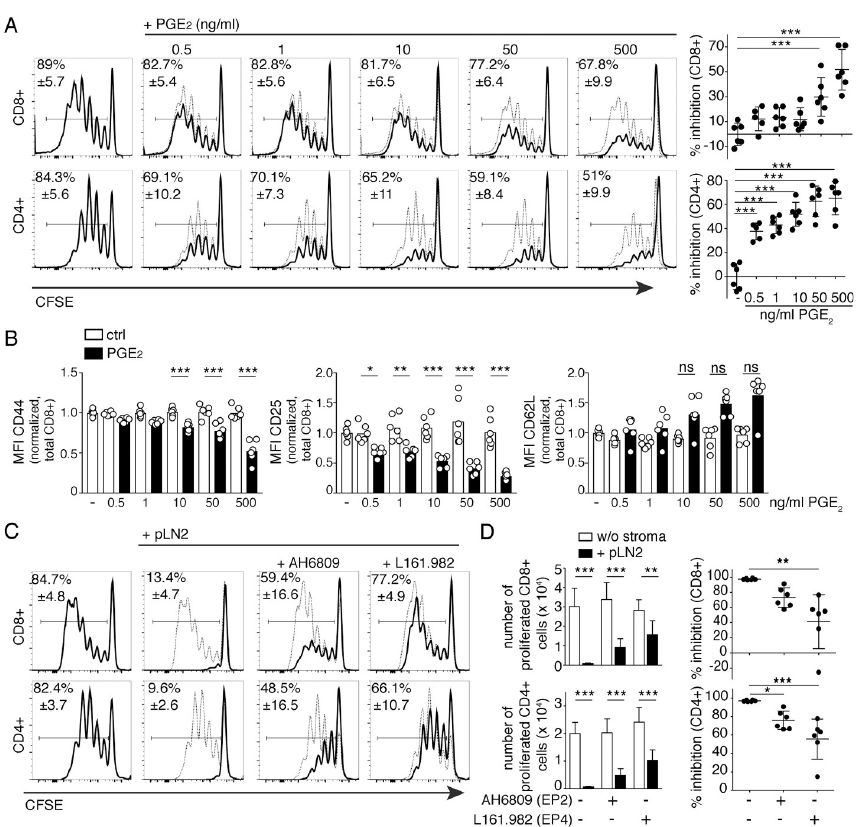
Fig 2. LN FRCs constitutively produce the COX-dependent mediator PGE 2 , which enables inhibition of T-cell activation and proliferation mainly via EP4 receptor signaling. Flow cytometric analysis of CFSE dilution in CD8+ and CD4+ T cells that were activated with α CD3/28 DynaBeads and cultured for 3 d. (A) Left side: CFSE dilution profiles of T cells in presence of the indicated concentrations of PGE 2 (black line) or solvent control (ethanol; thin line), with, on the right side, scatter plots showing the percentage inhibition of T-cell proliferation. (B) Expression level (MFI) of CD44, CD25, and CD62L on total CD8+ T cells in presence of PGE 2 . (C) CFSE profile of T cells cultured in presence (thick line) or absence (thin line) of pLN2 cells and the EP2 antagonist AH6809 (5 μ M) or the EP4 antagonist L161.982 (5 μ M). (D) Number of proliferated T cells (left side) and percentage inhibition of T-cell expansion (right side) as in (C). (A–D) Data are representative of 3 independent experiments ( n = 6). All bar graphs and scatter plots show mean ± SD. Statistics (A, B, C, and D): for comparison of multiple groups, ANOVA or Kruskal–Wallis followed by multiple comparisons was performed. Comparison of two groups (D) was with unpaired t test. � P < 0.05, �� P < 0.005, and ��� P < 0.001. Data used in the generation of this figure can be found in S1 Data. CD, cluster of differentiation; CFSE, carboxyfluorescein succinimidyl ester; COX, cyclooxgenase; ctrl, control; d, day; EP, E Prostanoid; FRC, fibroblastic reticular cell; LN, lymph node; MFI, median fluorescence intensity; ns, not significant; PGE 2 , prostaglandin E 2 ; pLN, peripheral LN; SD, standard